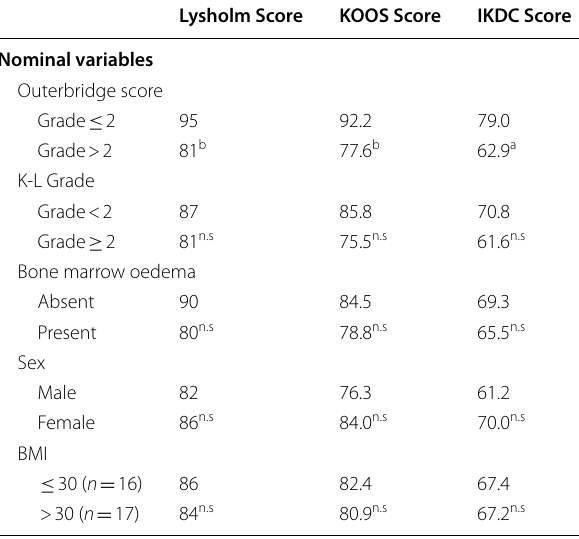
Nominal variable data compares preoperative factors to the mean postoperative clinical score IKDC International Knee Documentation Committee, KOOS Knee Injury and Osteoarthritis Outcome Score Mann–Whitney U tests were used a p <